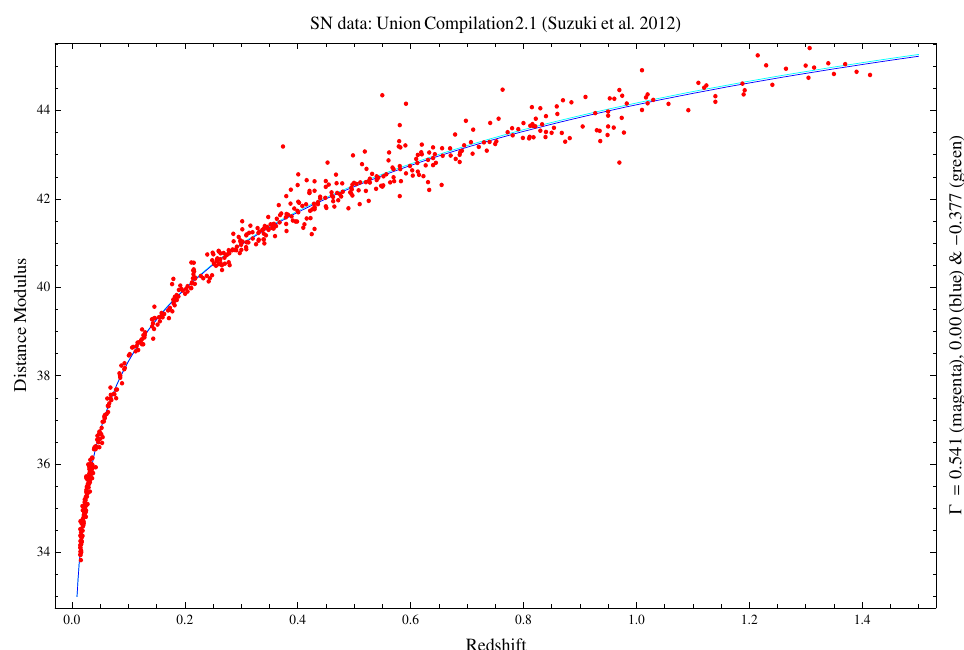
Figure 5. Hubble diagram of the Union 2.1 Compilation SNeIa data. Overplotted are three theo- retically determined curves representing the distance modulus in the polytropic DM model, i.e., Equation